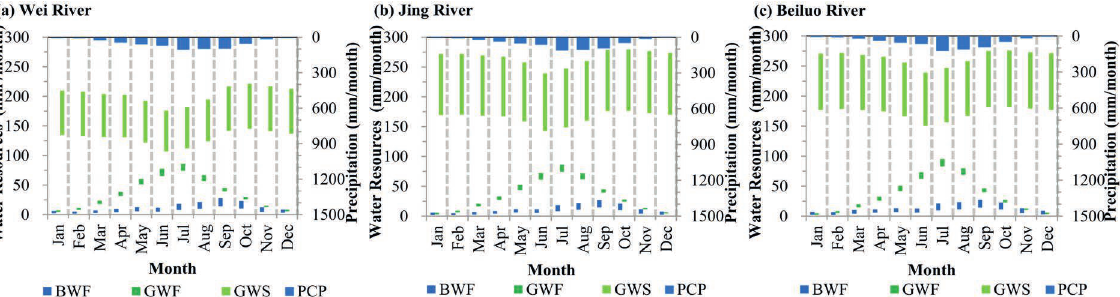
Fig. 5 Average (1964–2008) monthly 95PPU ranges of the blue water flow, the green water flow, and the green water storage in the Wei River (a), Jing River (b), and Beiluo River (c) catchments.